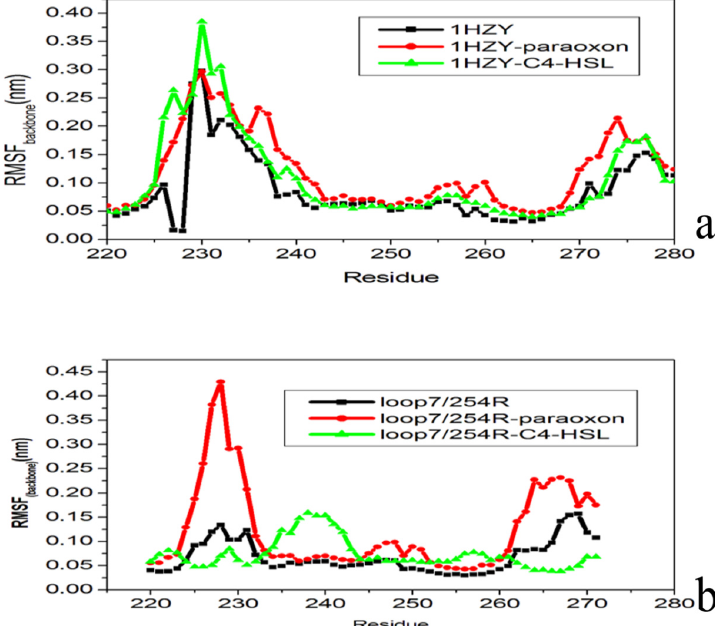
Figure 8. Atom-positional root-mean-square fluctuations (RMSF) of backbone atoms averaged per residue (amino acid 220 to 280) ( a ) for PTE (1HYZ) substrate free (black), substrate-bound (1HYZ- paraoxon (red) and 1HYZ-C4-HSL (green); ( b ) for loop7-2/H254 R variant substrate (black), substrate-bound (loop7-2/H254 R - paraoxon (red) and loo7-2/H254 R-C4-HSL). Values are averaged for the two OPH monomers and over 30 ns of